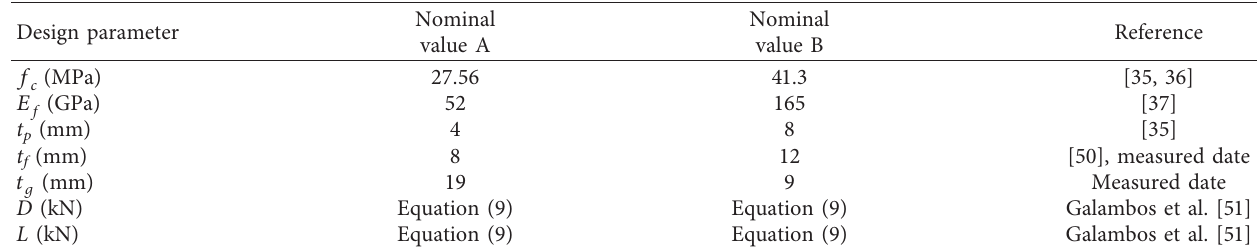
Table 14: Two groups of nominal parameters for the reliability